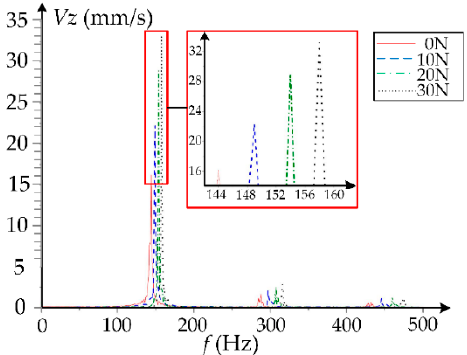
Figure 5. The trend of the dimensionless inlet distance at different oil flow rates.